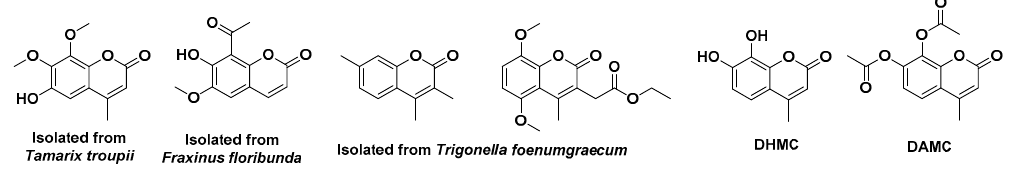
Figure 1. Biologically-important coumarins.